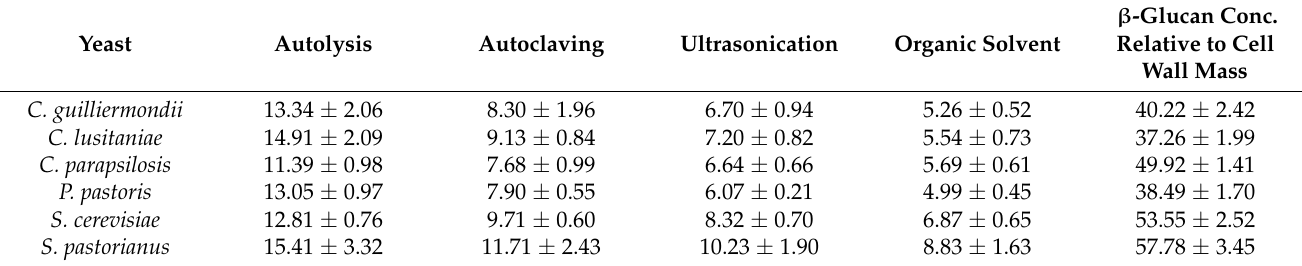
Table 1. Percent (%) of dried cell wall extracts mass relative to yeast cell biomass during different stages of hot water extraction. Values are an average of triplicate observations; ± standard